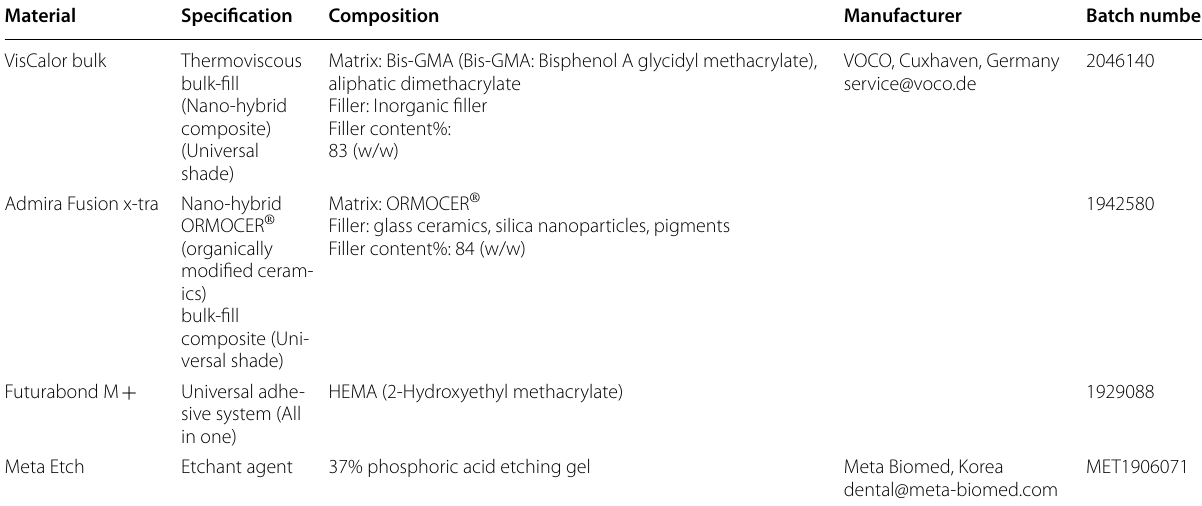
Table 1 Materials, specification, composition, manufacturers, and batch number